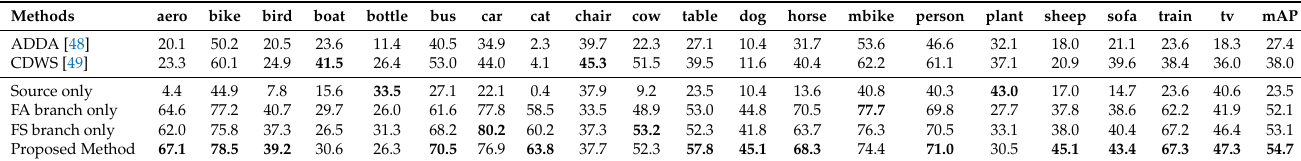
Table 3. The mean Average Precision (mAP) of different models on DT Clipart test set for Pascal VOC → DT Clipart transfer. The best results are in